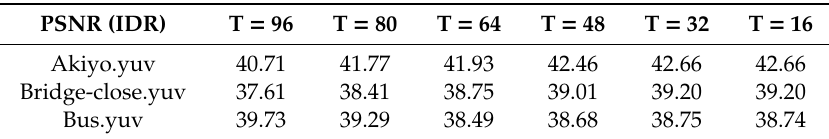
Table 4. Video quality experimental results of the IDR